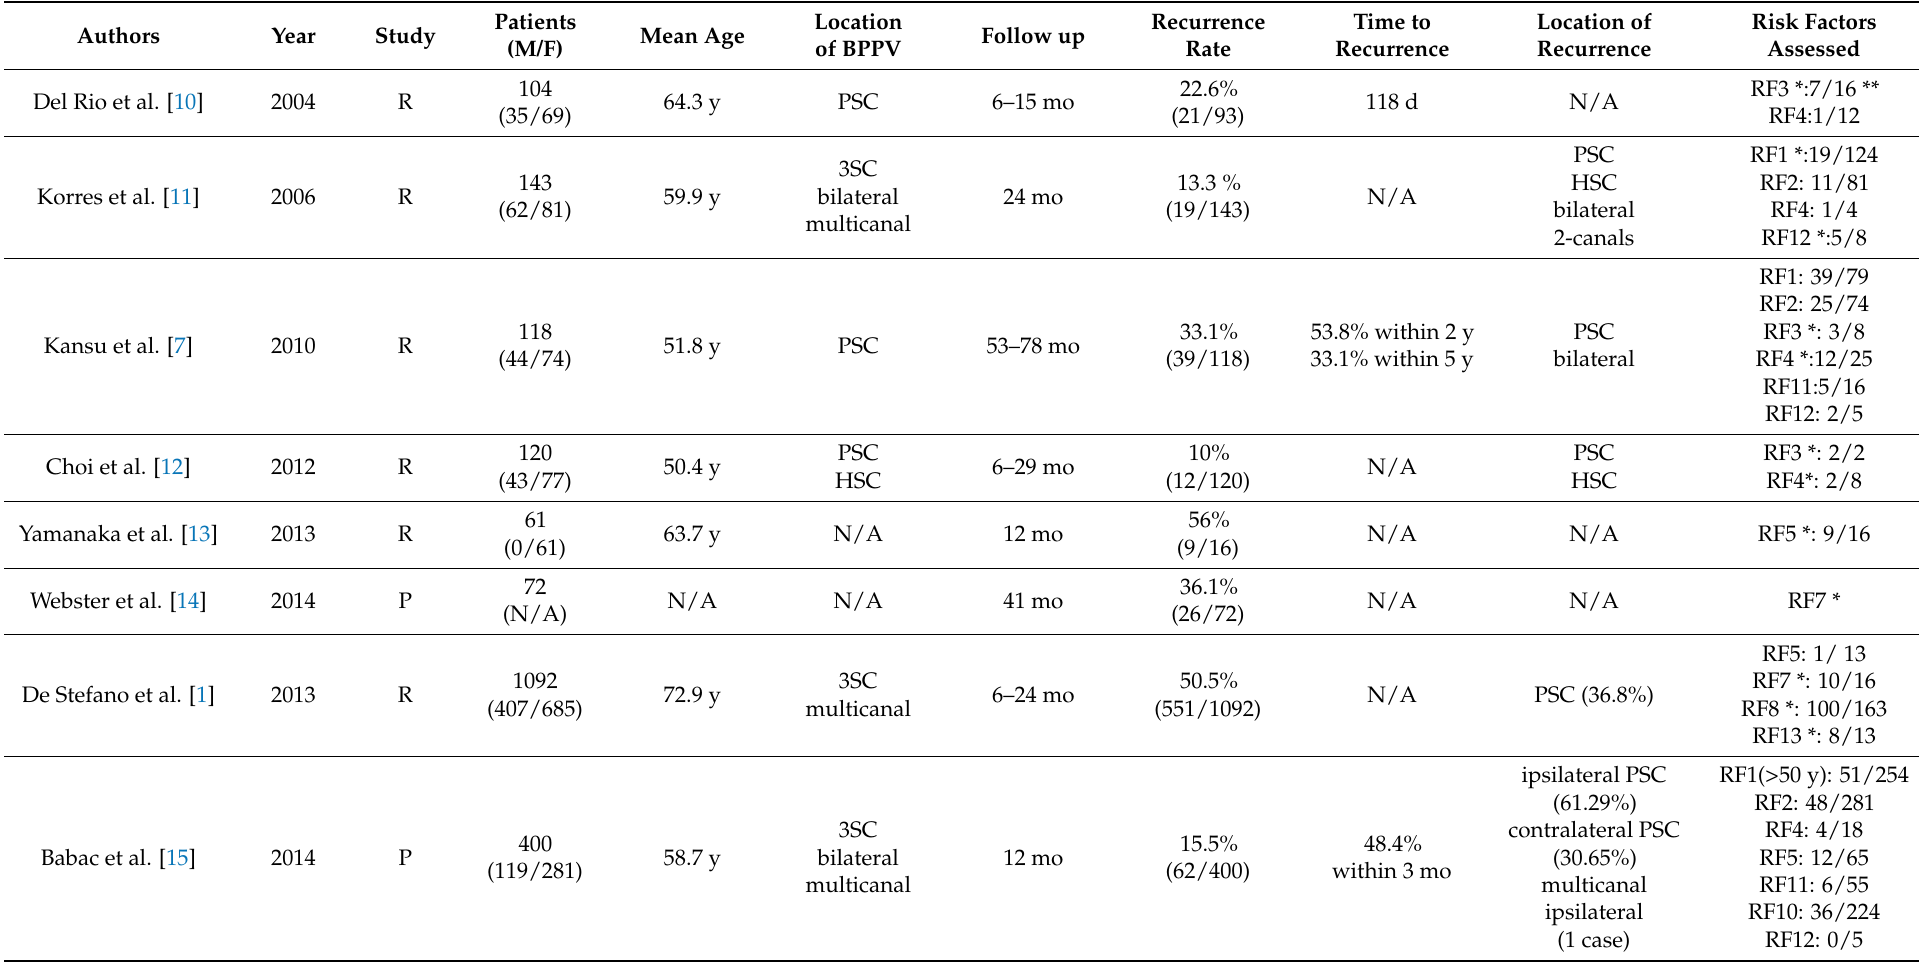
Table 1. Assessed characteristics of the included